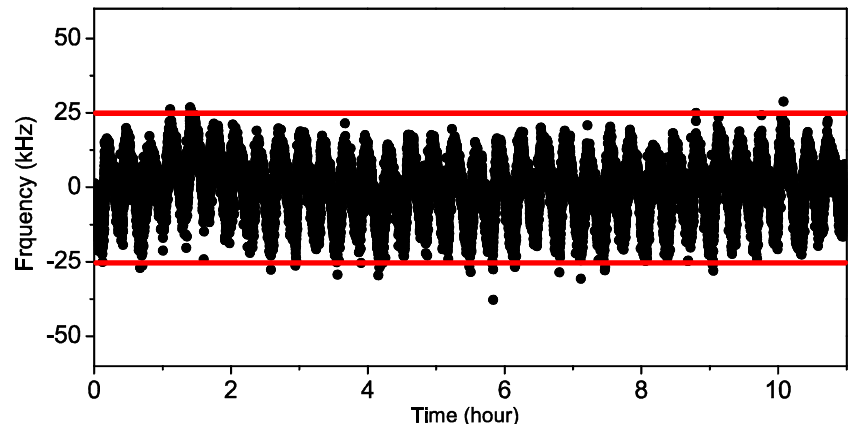
Figure 5. Beat note between the reference laser and the optical frequency comb.